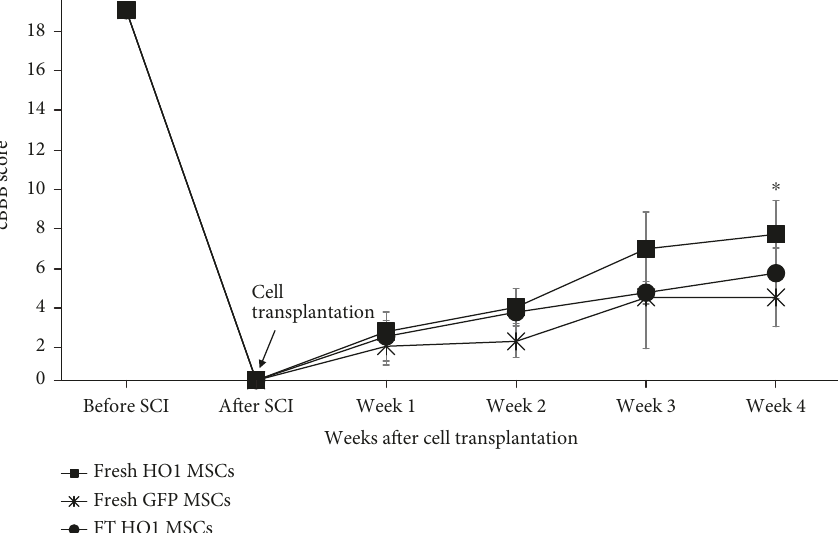
Figure 4: Improvement in cBBB score during the 4 weeks following cell transplantation. ∗ Indicates signi fi cance at p ≤ 0 05 among the groups. Each point represents the average of 4 samples and error bars represent standard